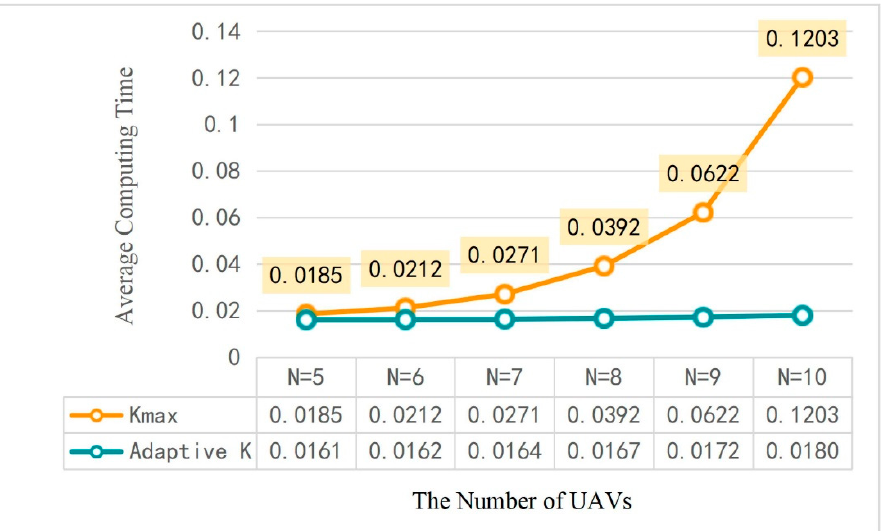
Figure 6. When the number of UAVs is 5 to 10, the DOTO algorithm uses full enumeration ( K max ) and adaptive K modes to average the computing time per time block within 10,000 time blocks.